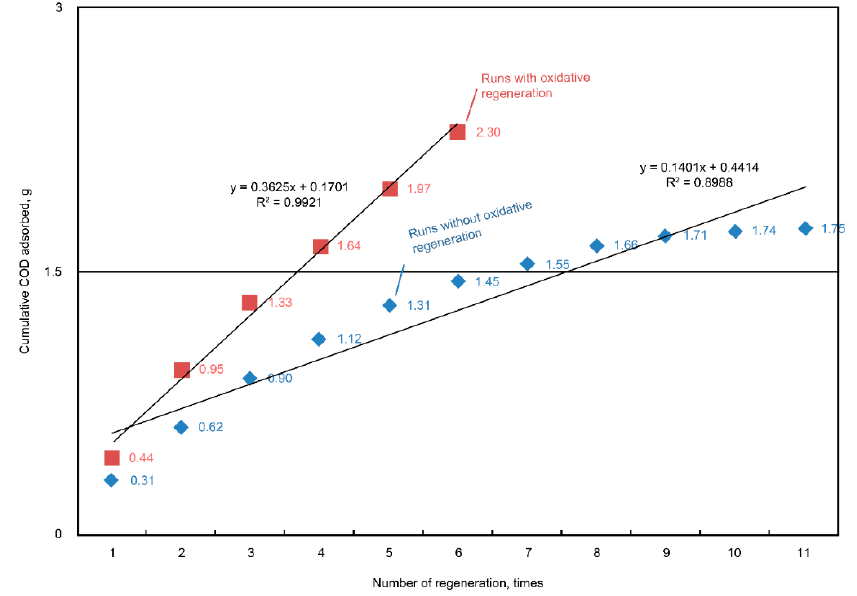
Figure 9. Plots of the cumulative COD adsorbed over the consecutive daily operations of AC ad- sorption and regeneration. The results showed a linear increase in terms of the cumulative COD adsorption during each adsorption–oxidation cycle.